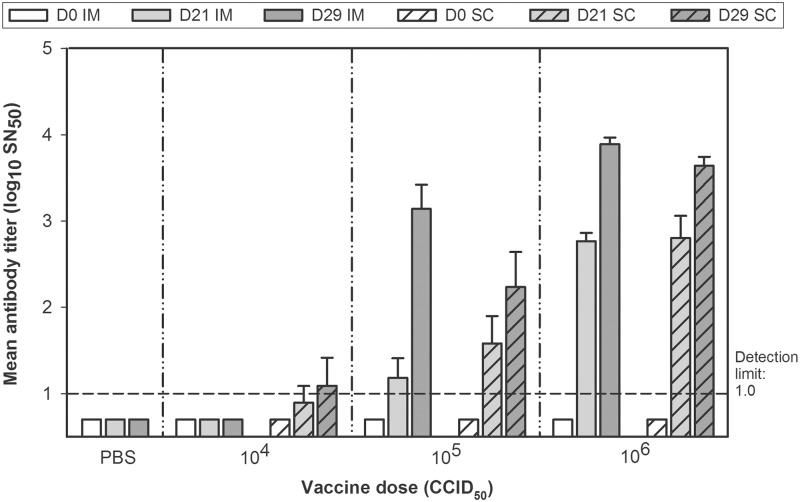
Guinea pigs immunized with HSV529 produce antibodies that neutralize HSV-2 infection in vitro.Guinea pigs were immunized with HSV529 (104 CCID50, 105 CCID50, or 106 CCID50) by the intramuscular (IM; n = 5 each) or subcutaneous (SC; n = 5 each) route or with PBS (n = 3) by the intramuscular route on days 0 (D0) and 21 (D21). Sera were collected from all animals on days 21 and 29 (D29) and measured for HSV-2 neutralizing activity by preincubating dilutions of heat-inactivated sera with 100 CCID50 of live HSV-2 virus for 1 hour prior to infection of Vero cell cultures. Infected cells were detected with anti-HSV glycoprotein D antibodies. The serum dilution that neutralized 50% of the virus (SN50) was determined by plotting the neutralization activity versus the serum dilutions. Error bars represent standard error of the mean.